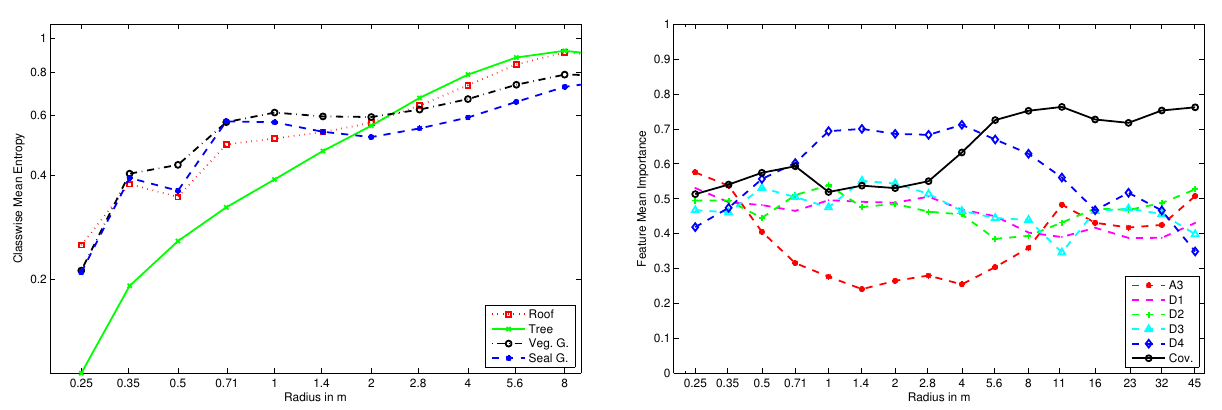
Figure 5: Mean rank of mean feature relevance per feature group for different neighbourhood sizes. A3, D1, D2, D3 and D4 are the shape distribution features described in Section 2.2.2, and Cov.